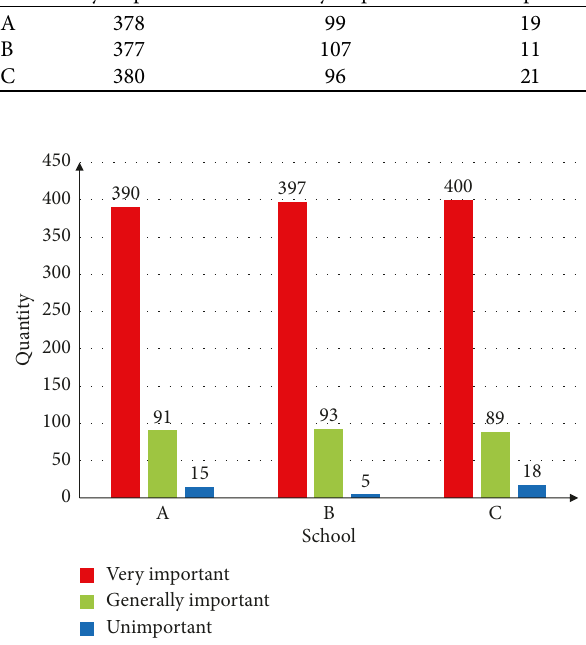
Figure 5: Results of the survey in the evaluation of physical ed- ucation students’ self-innovation